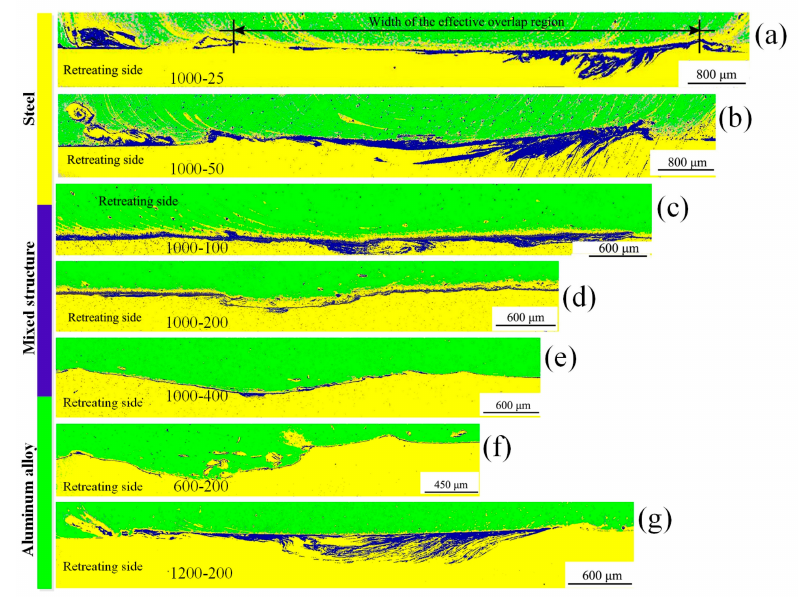
Figure 4. Macrographs of the joint interface showing distinctive interfacial features for weld made with different welding speeds and rotation speeds.